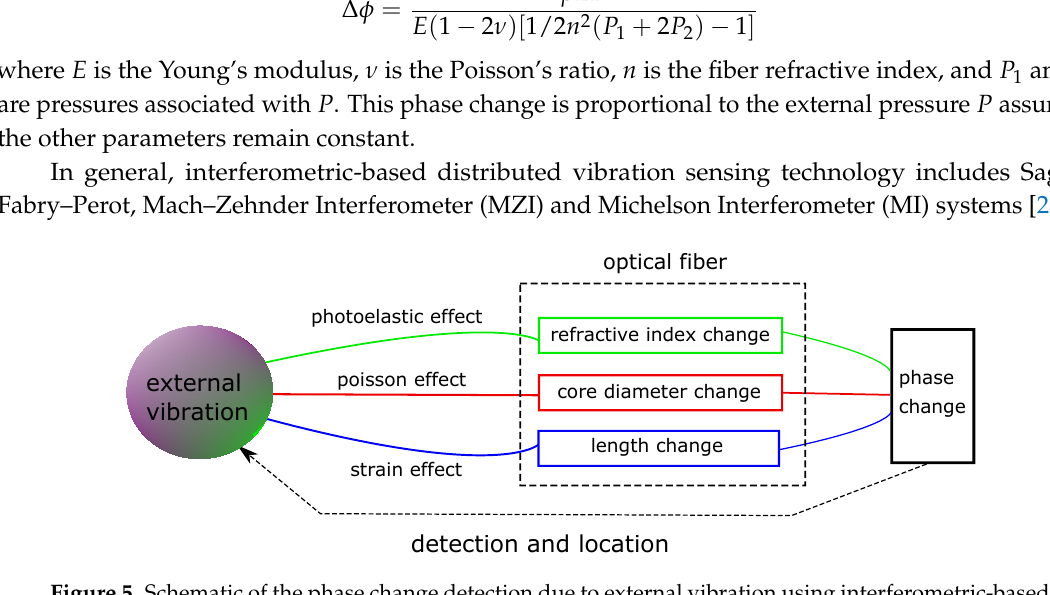
Figure 5. Schematic of the phase change detection due to external vibration using interferometric-based fiber-optic sensing. (Adapted from